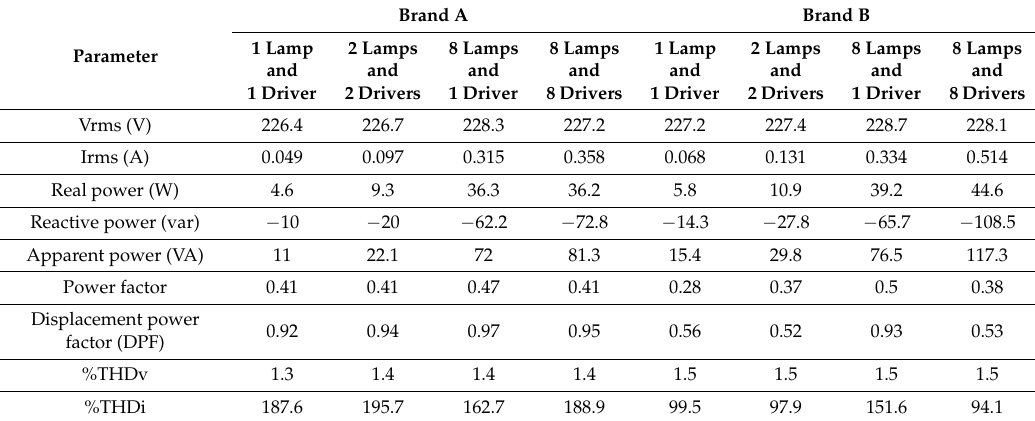
Table 3. Summary results from experimental setup for each driver brand.